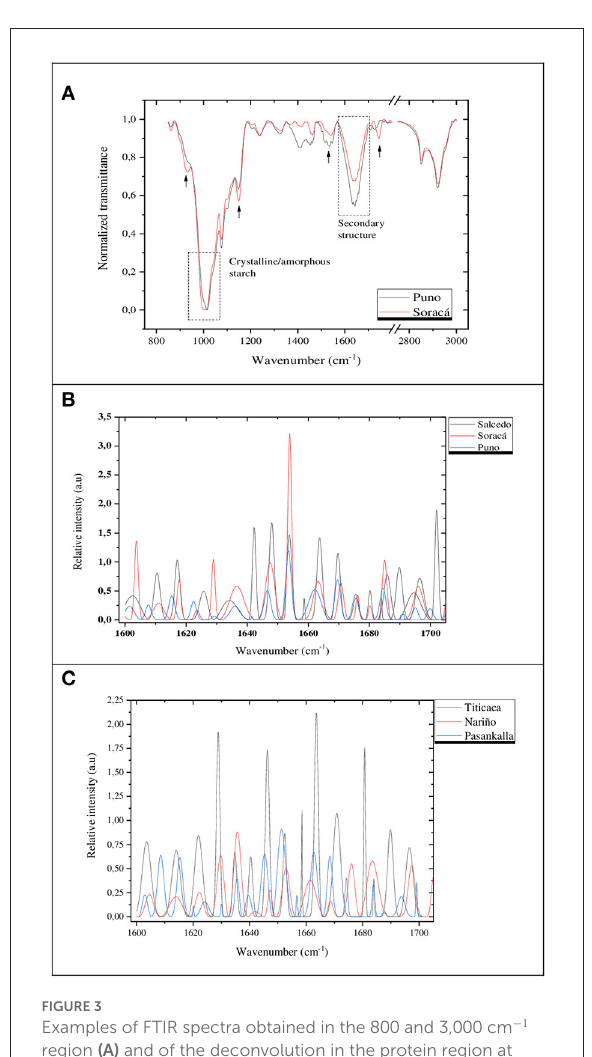
FIGURE3 Examples of FTIR spectra obtained in the 800 and 3,000 cm − 1 region (A) and of the deconvolution in the protein region at 1,600 and 1,710 cm − 1 (B,C)